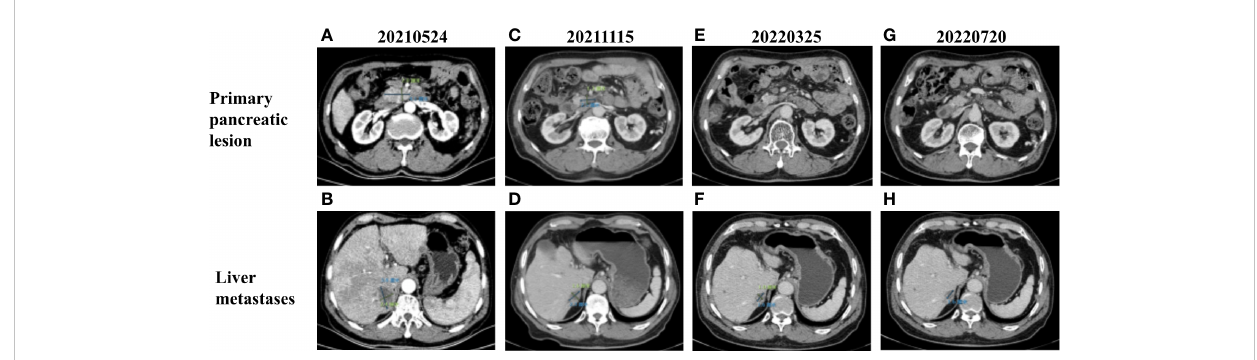
FIGURE 2 (A) CT images of primary pancreatic lesion with a size of 4.1 cm × 2 cm before treatment. (B) CT images of liver metastases with a size of 3.8 cm × 2.4 cm before treatment. Contrast-enhanced CT scan images completed in (C, D) November 2021, (E, F) March 2022, and (G, H) July 2022 demonstrating progressive decrease in the size of primary pancreatic and liver